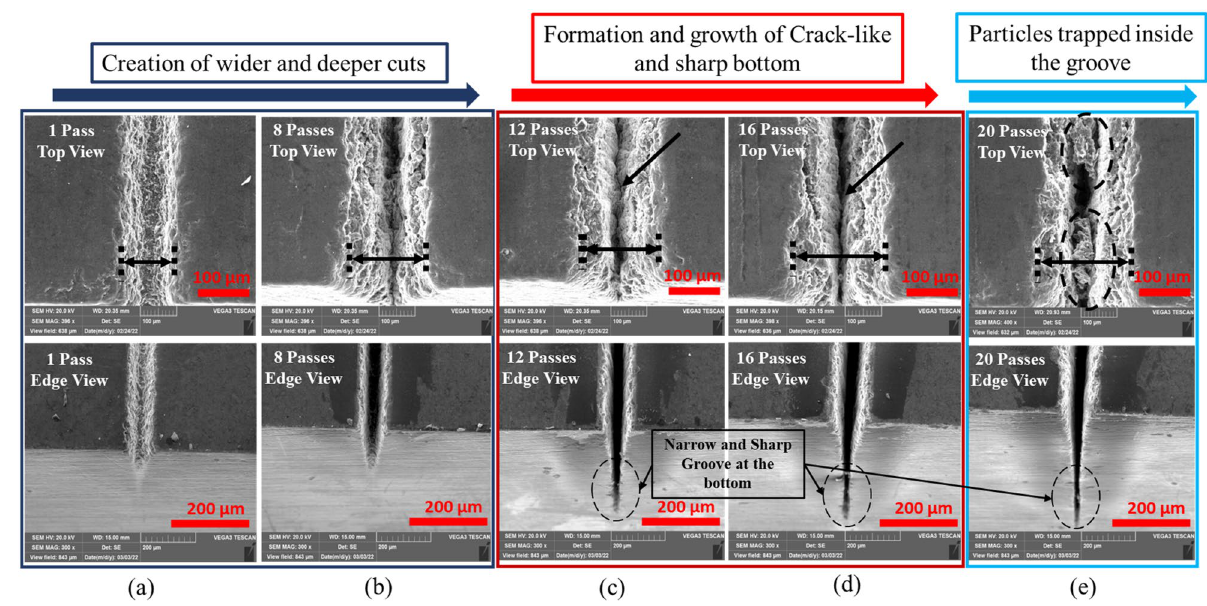
Figure 10. Effect of number of passes; ( a ) 1pass, ( b ) 8passes, ( c ) 12passes, ( d ) 16passes and ( e ) 20passes [Fixed: 20 kHz, 200 ns, 20W and 100